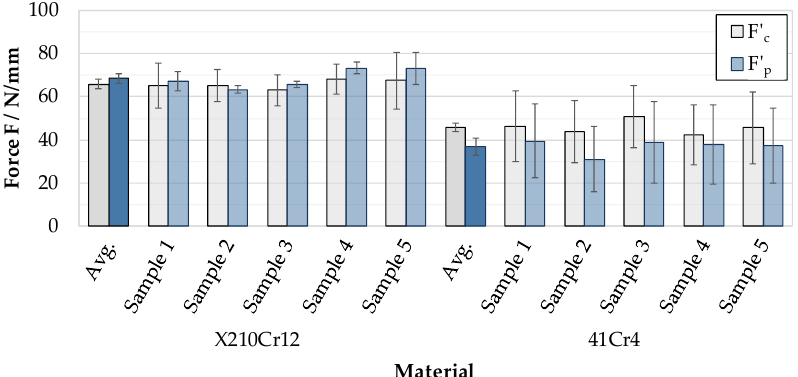
Figure 8. Averaged and individual results of cutting force F’ c and specific thrust force F’ p measurements obtained during micro machining.